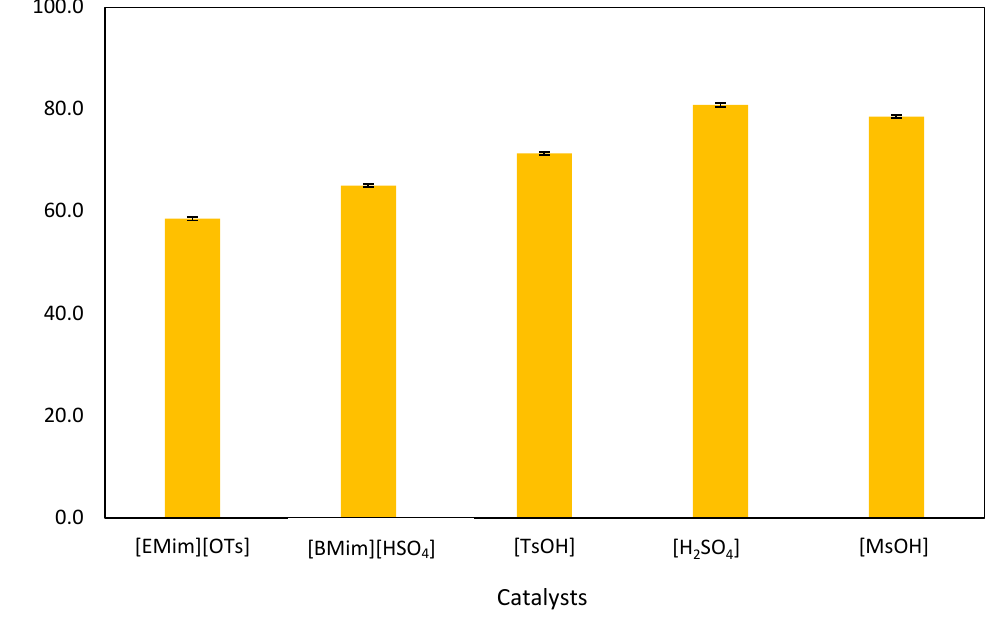
Figure 5. E ff ect of catalysts on GVL production from LA. Figure 5. Effect of catalysts on GVL production from